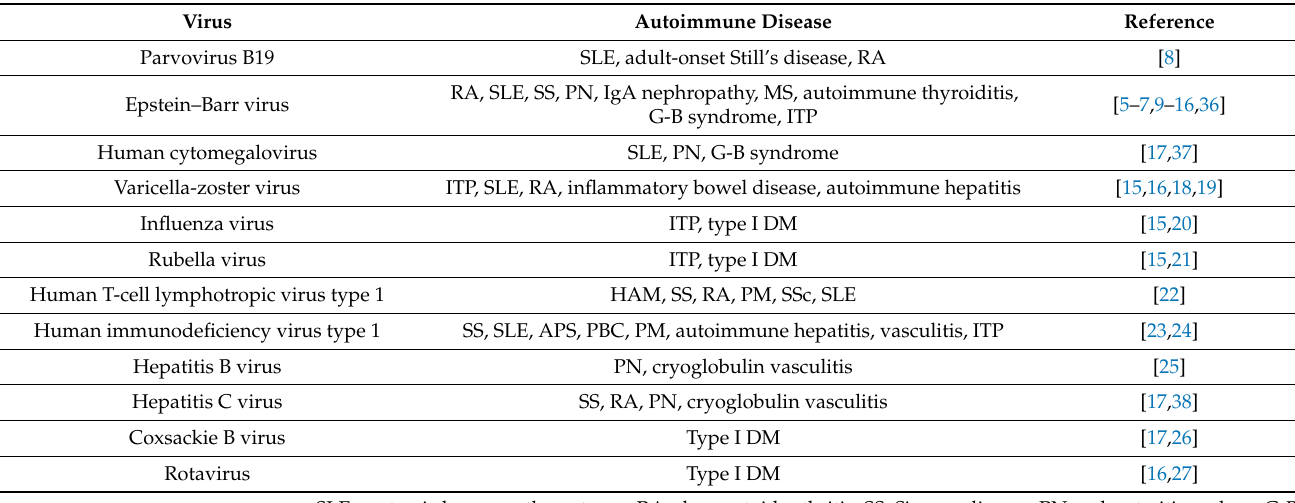
Table 1. Association of viral infections with autoimmune diseases.